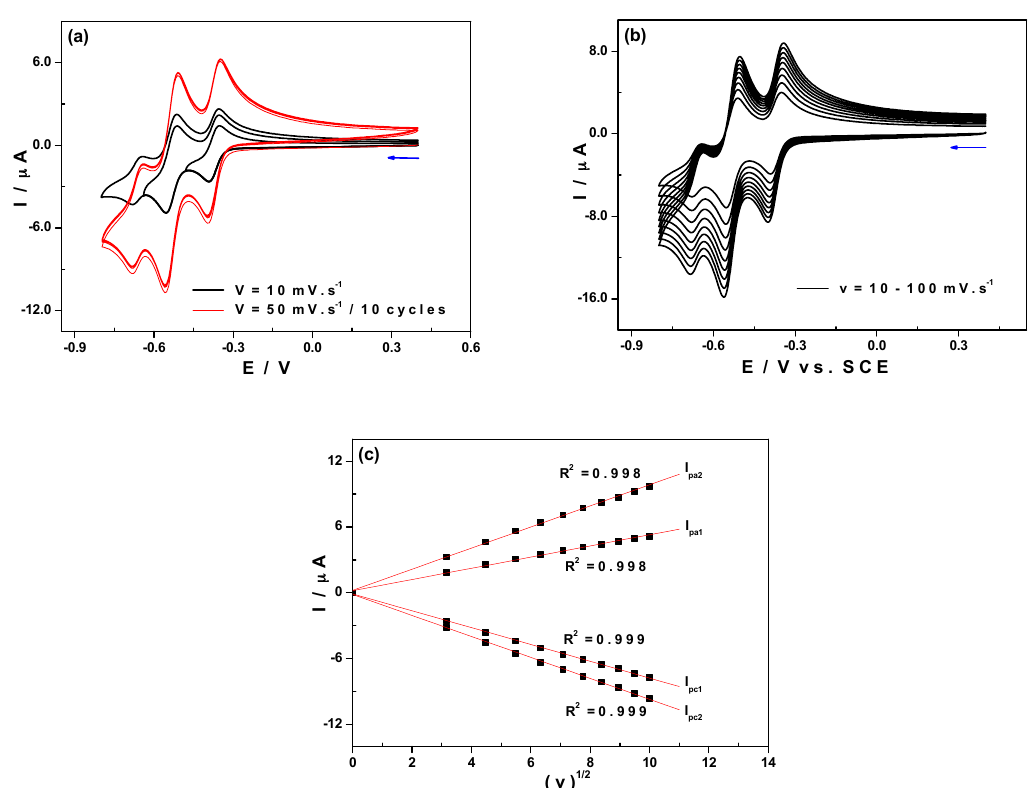
Figure 2. Cyclic voltammetry curves (CVs) of 1 at pH 3 (0.5M Li 2 SO 4 + H 2 SO 4 ); Polyoxometalate (POM) concentration: 0.5 mM. Reference electrode: Saturated Calomel Electrode (SCE). ( a ) Potentials were scanned between +0.4 and − 0.8 V at 10 mV · s − 1 (black lines) followed by ten successive cycles at 50 mV · s − 1 (red lines); ( b )The scan rates from the inner to the outer curve are 10, 20, 30, 40, 50, 60, 70, 80, 90 and 100 mV · s − 1 ; ( c ) Variations of cathodic and anodic peak current intensities (for the first and the second signals) as a function of the square root of the scan